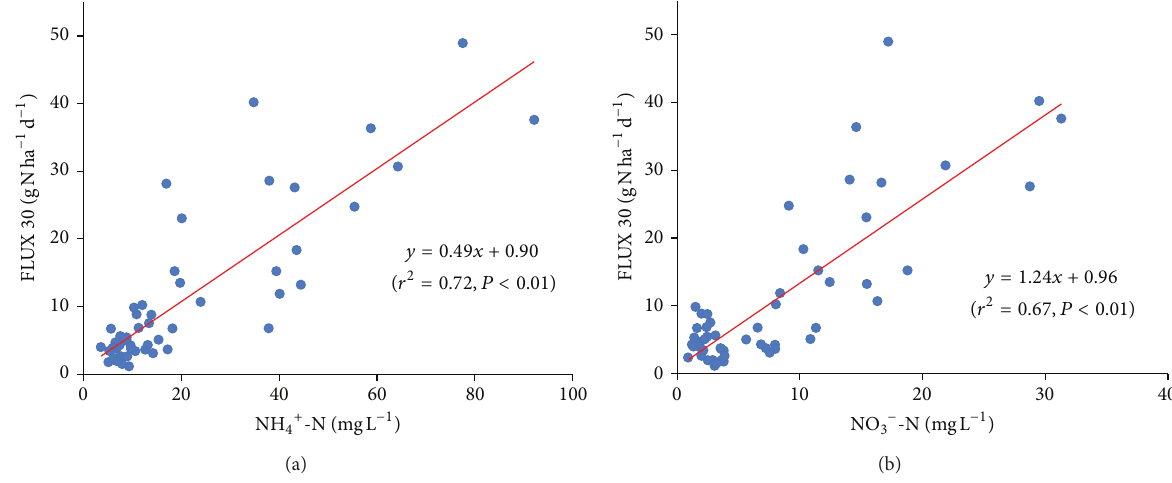
Figure 4: Relationships between N 2 O emissions from the tea field and soil concentrations of (a) NH 4+ -N and (b) NO 3− -N.